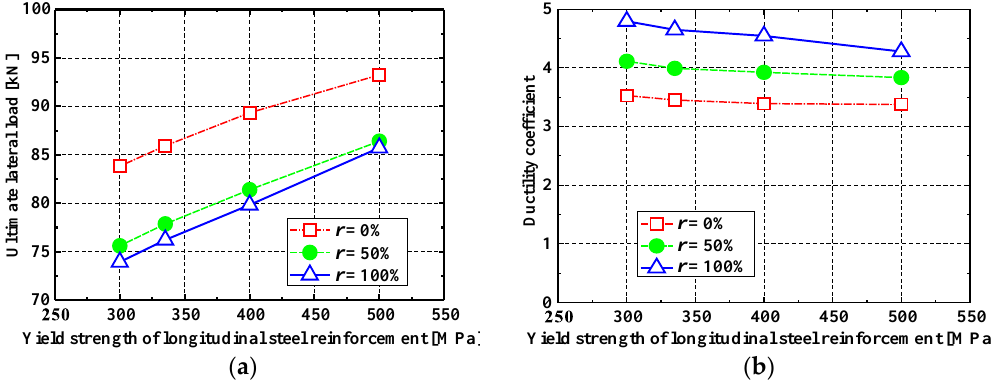
Figure 11. Effect of steel yield strength on seismic performance of RRC columns. ( a ) Capacity. ( b ) Ductility.